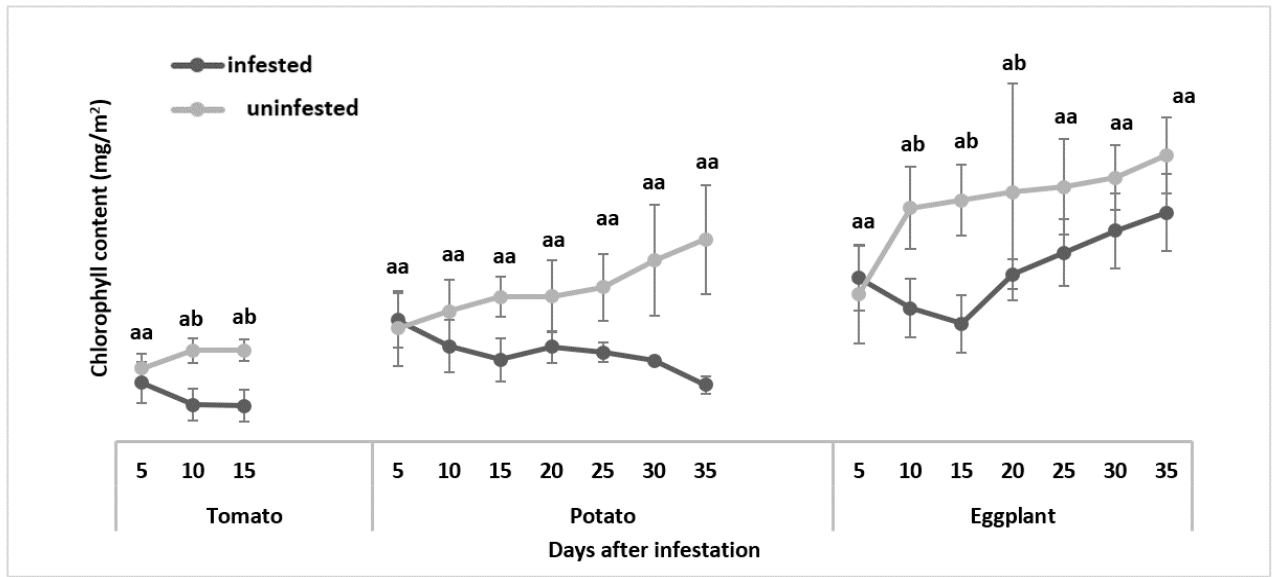
Figure 8. Comparison of mean chlorophyll content between the uninfested and Tuta absoluta -infested plants. Means followed by different letters in the same bar column are significantly different at p < 0.05.